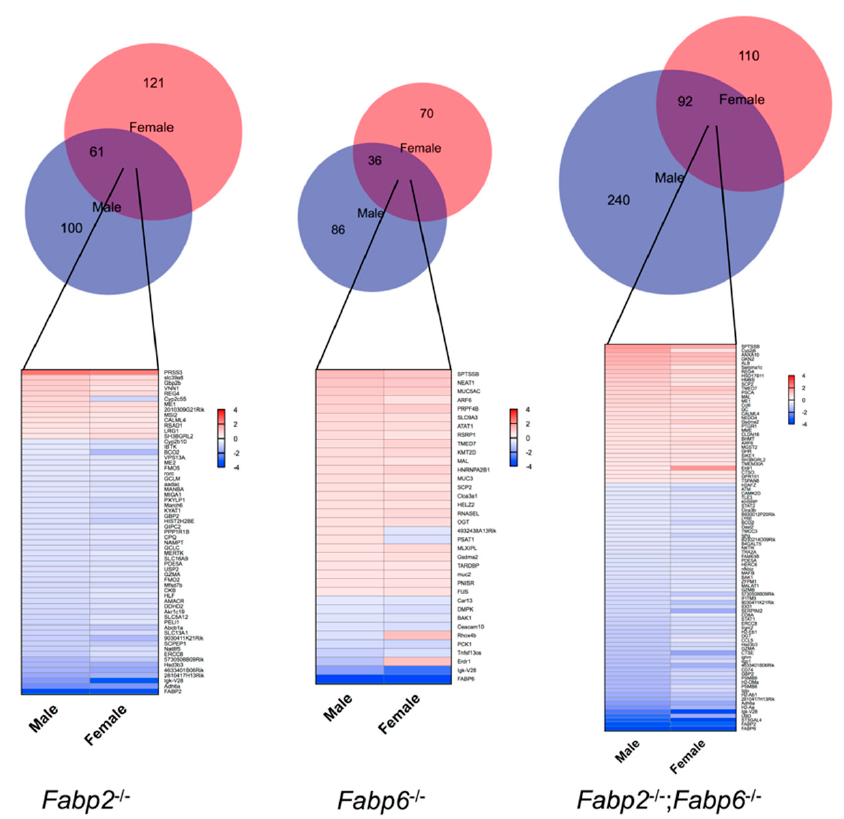
Figure 2. The comparison of the di ff erentially expressed (DE) genes in di ff erent Fabp gene-disrupted male and female mice. The Venn Diagram of the common and sex-specific DE genes induced by the deletion of Fabp genes (top). The heatmap comparing the altered expression of the common DE genes shared by males and females (bottom). See Supplementary Table S1 for a complete list of DE genes. To gain insight into the metabolic pathways di ff erentially a ff ected in males and females by Fabp gene ablations, gene ontology analysis using DE genes grouped by sex for each genotype was carried out. The top 10 biological processes having a p -value < 0.05 are shown in Table 1. Two groups of proportion of a ff ected processes. Specifically, DE genes influenced by Fabp2 or Fabp6 gene